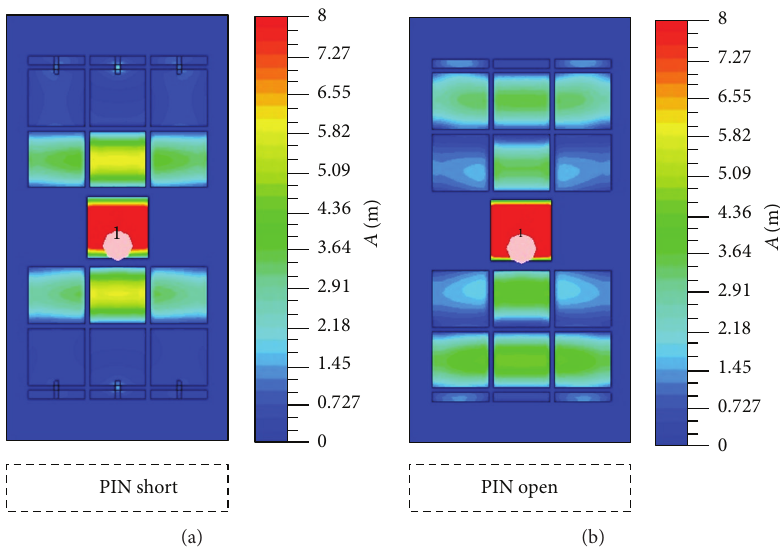
Figure 5: Surface currents on EBG antenna. (a) PIN diodes shorted. (b) PIN diodes open.